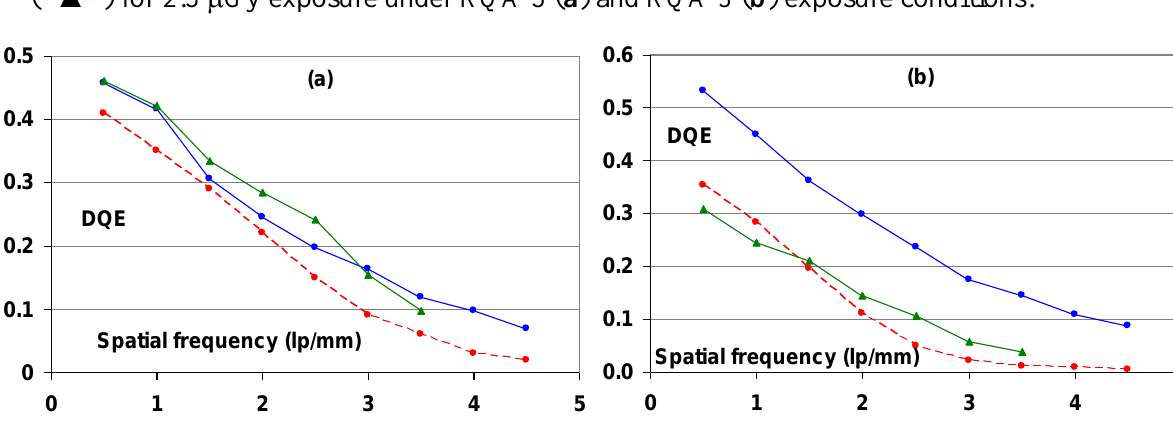
Figure 39. DQE of DX-S  with NIP (--•--) of DX-G  with NIP (  •  ) and of DX-D 500  (  ▲  ) for 2.5  Gy exposure under RQA 5 ( a ) and RQA 3 ( b ) exposure